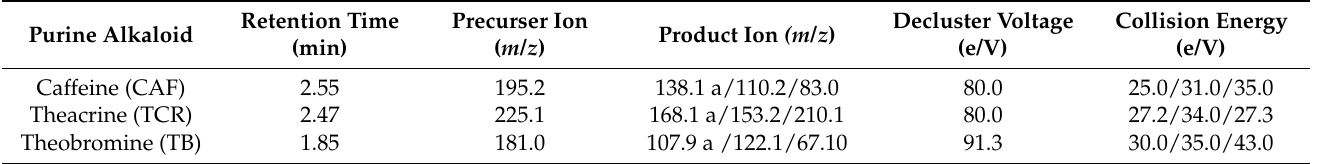
Table 2. UPLC-MS/MS parameters of purine